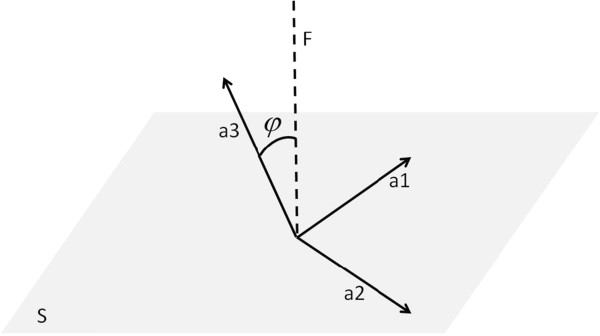
The definition of φ. S is the plane that line a1 and line a2 forms, line F is the normal line of plane S, and φ is the angle between line F and line a3.